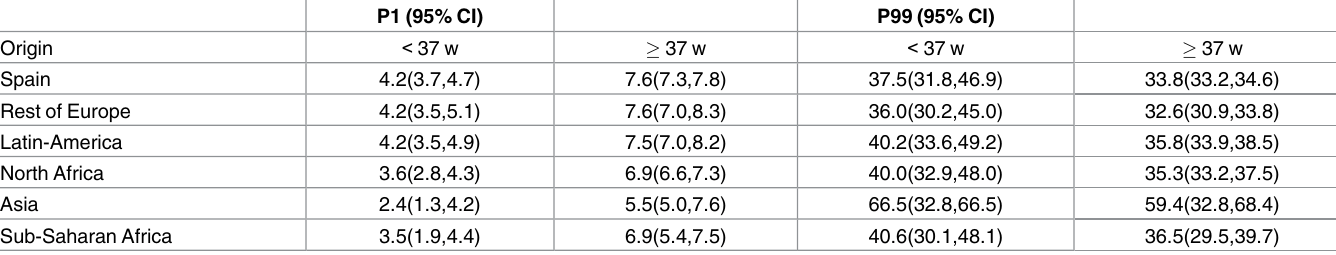
Table 1. Atypical hemoglobin A values (%) according to maternal origin and gestational age for male gender.